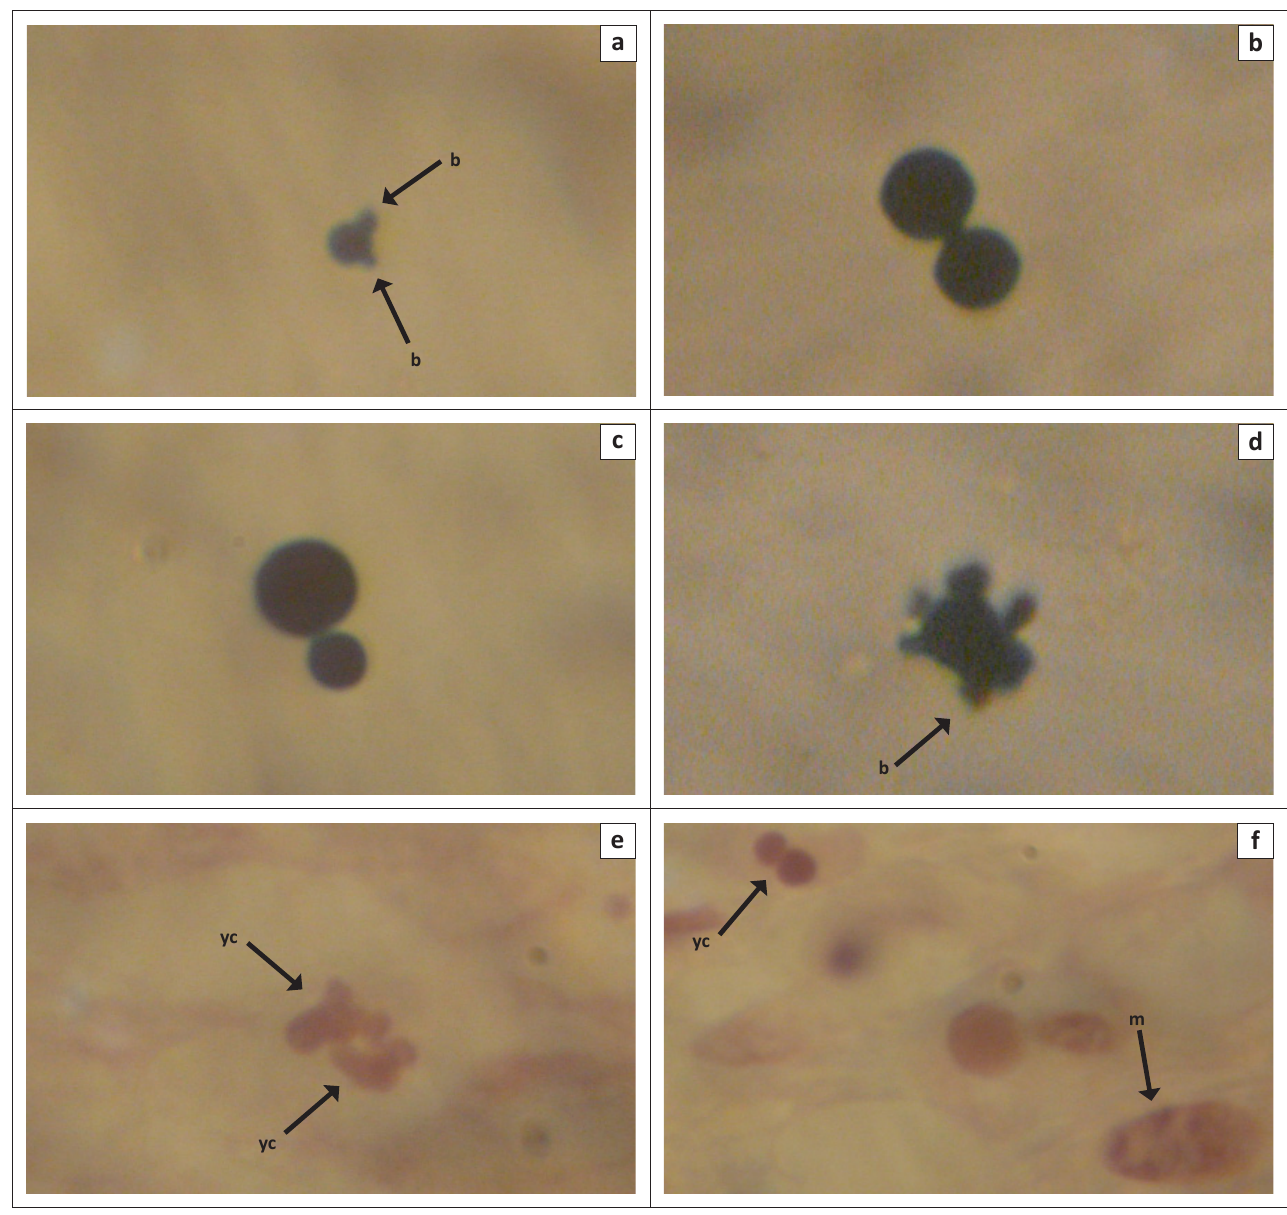
FIGURE 1: Photomicrographs of dimorphic fungi observed in tuberculous lesions in beef cattle in Kenya, (a) Paracoccidioides brasiliensis and (b) Blastomyces dermatitidis fungal cells in lymph node lesion smears, (ZN × 1000); (c) P. brasiliensis and (d) B . dermatitidis cells in BBL cultures, (ZN × 1000). Note the multiple buds, shown at b, on the flattened P. brasiliensis cell; (e) P. brasiliensis and (f) B . dermatitidis yeast cells in lymph node sections, (PAS x